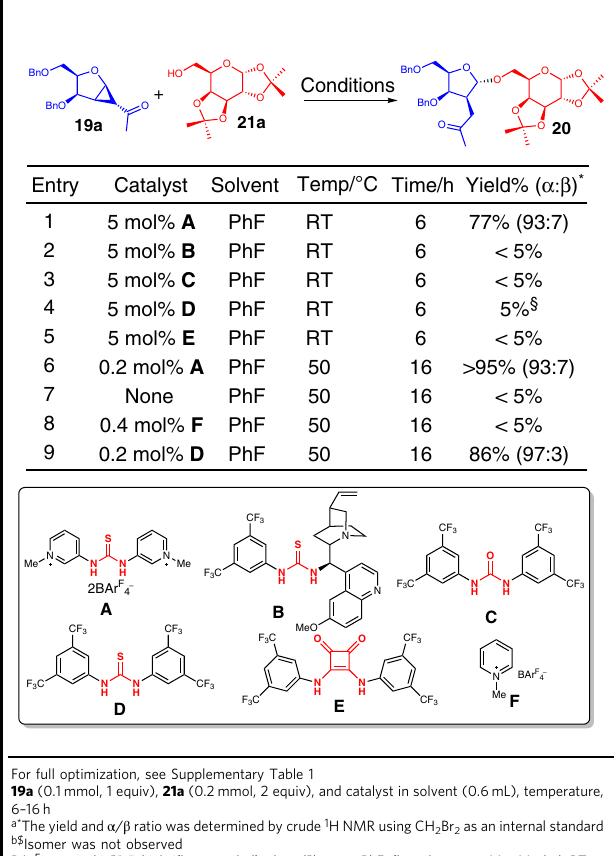
Table 1 Representative reaction optimization and screening